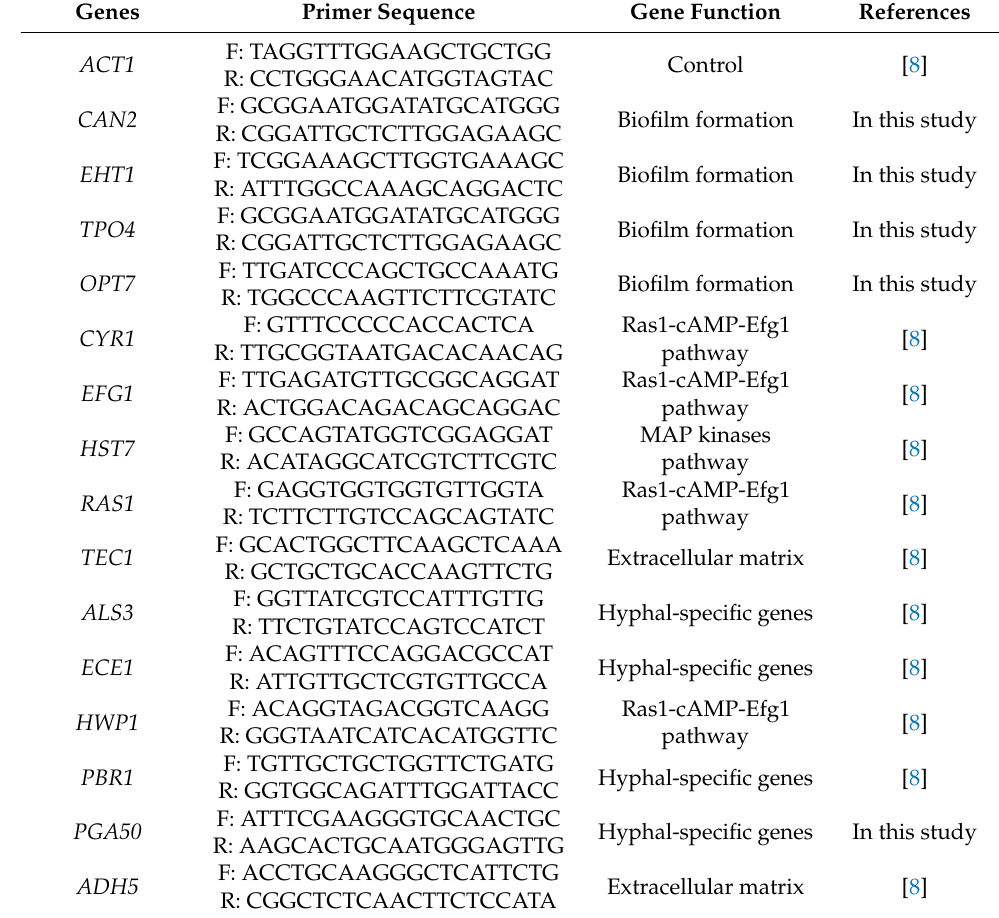
Table 3. Gene specific primers used for real-time RT-PCR. Genes Primer